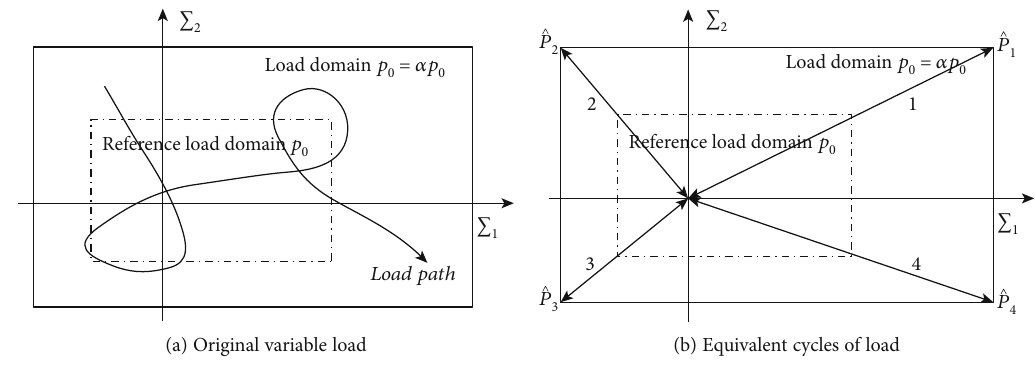
Figure 3: Transformation of the variable load within a given load